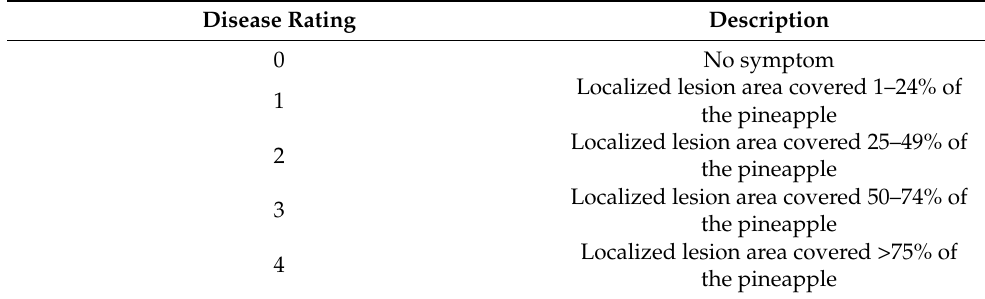
Table 5. The disease rating of localized lesions of pineapple fruitlets (developed from this